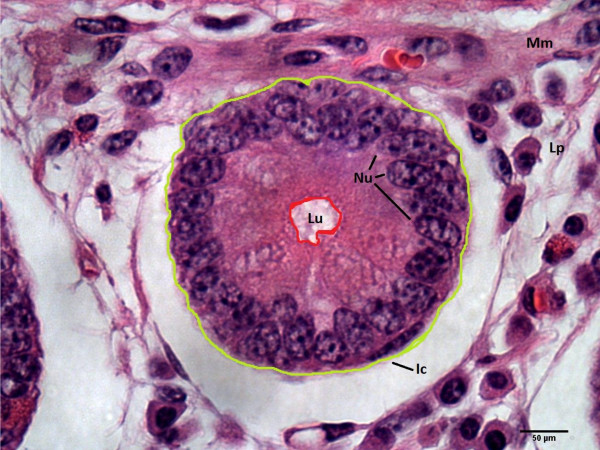
Light microscopy of an oblique cross section of the intestinal mucosa (1000× capture magnification). Note the intestinal crypt (Ic) adjacent to the muscularis mucosae (Mm), the lumen of the intestinal crypt (Lu), the nuclei of intestinal cells (Nu) around the intestinal crypt and the lamina propria (Lp). The green and red contours were used to obtain measures of the intestinal crypt and the intestinal crypt lumen, respectively.